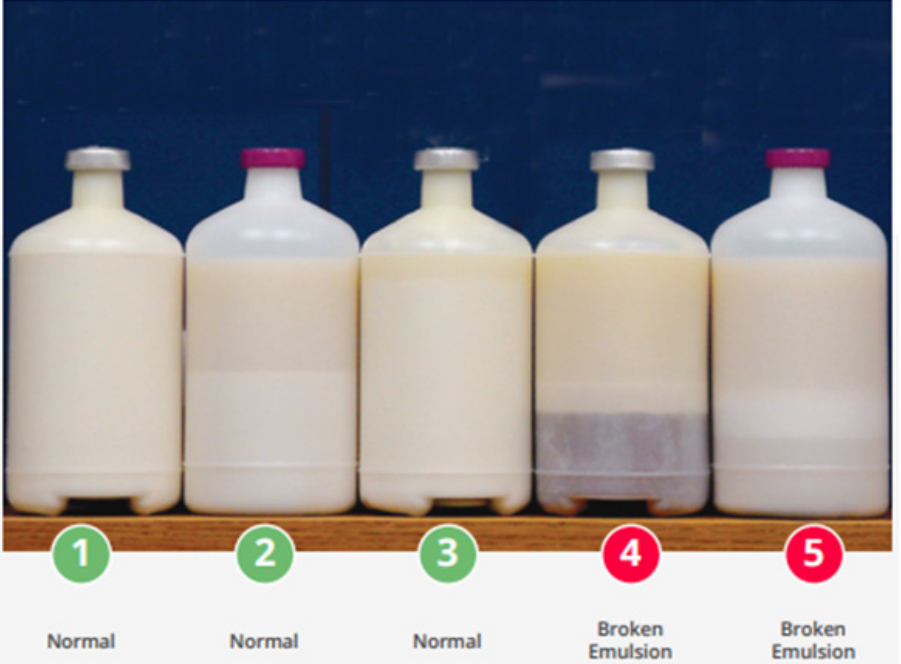
Figure 6. Broken emulsion shown in inactivated killed vaccine is caused by mishandling and stor- age issue (Source: www.cobb-vantress.com accessed on 28 December 2020).